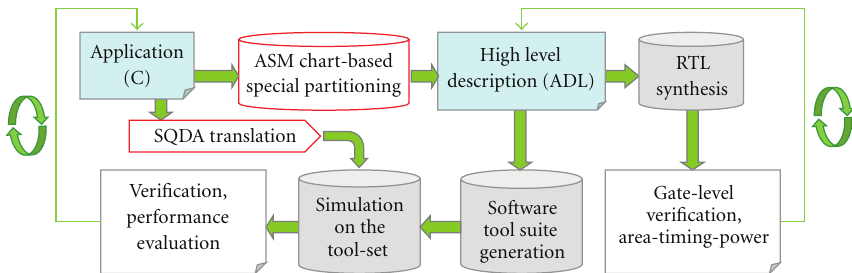
Figure 4: LISA design flow with the proposed enhancements.